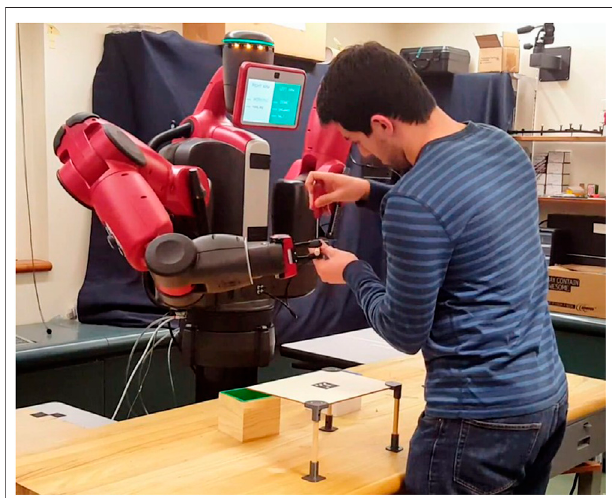
Algorithm 1. Algorithm to simulate potential future hypotheses